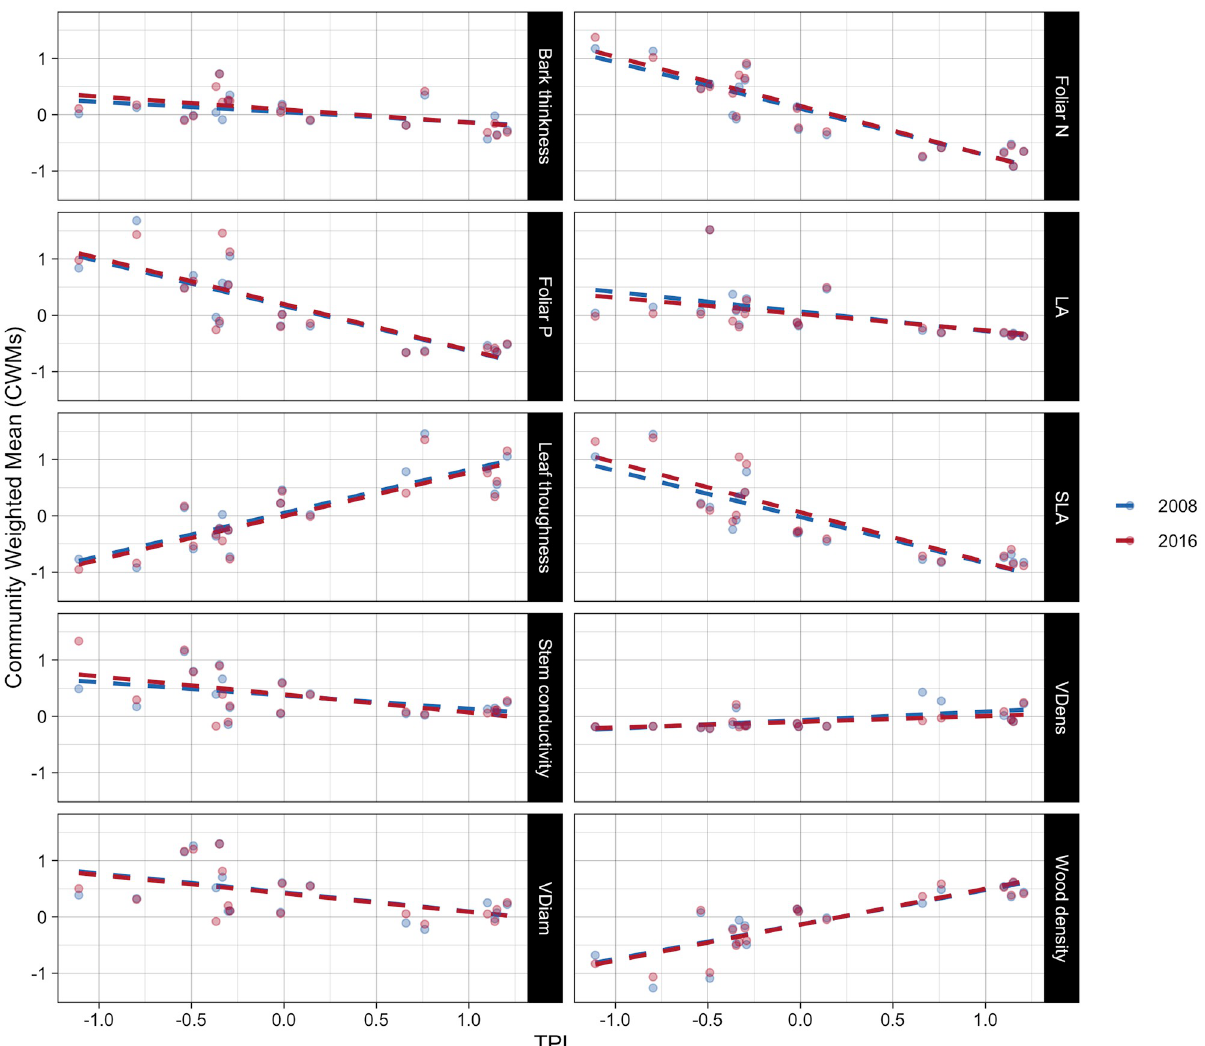
Fig 5. Community Temperature Index (A) and Community Precipitation Index (B) for the community’s demographic groups along a topographic gradient (Topographic Position Index = TPI). Lines indicate statistically significant linear regressions ( P � 0.05). Each point represents a forest monitoring